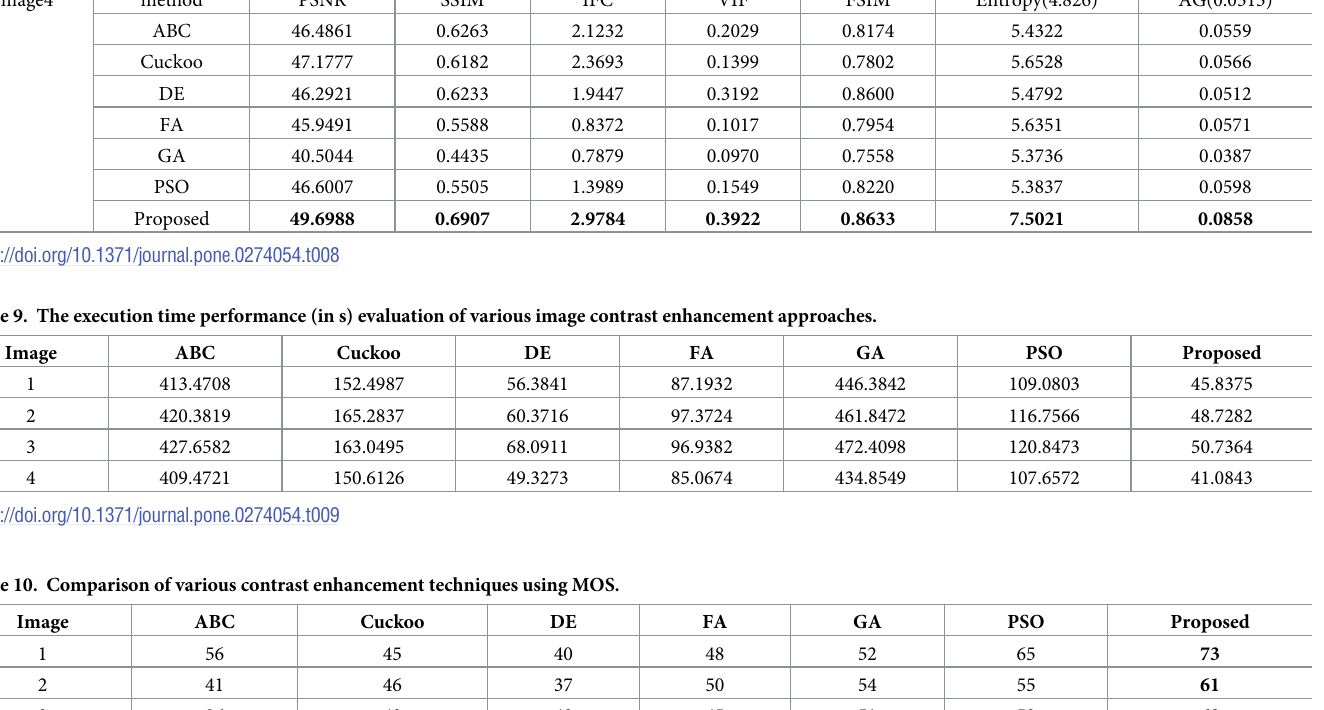
Table 8. The performance evaluation of various image contrast enhancement approaches using test images 4. Image4